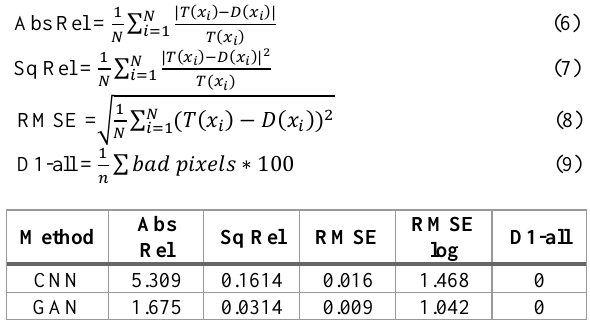
Table 2. Metrics on the internal accuracy between the disparity image during training and testing for the two models (in pixels).